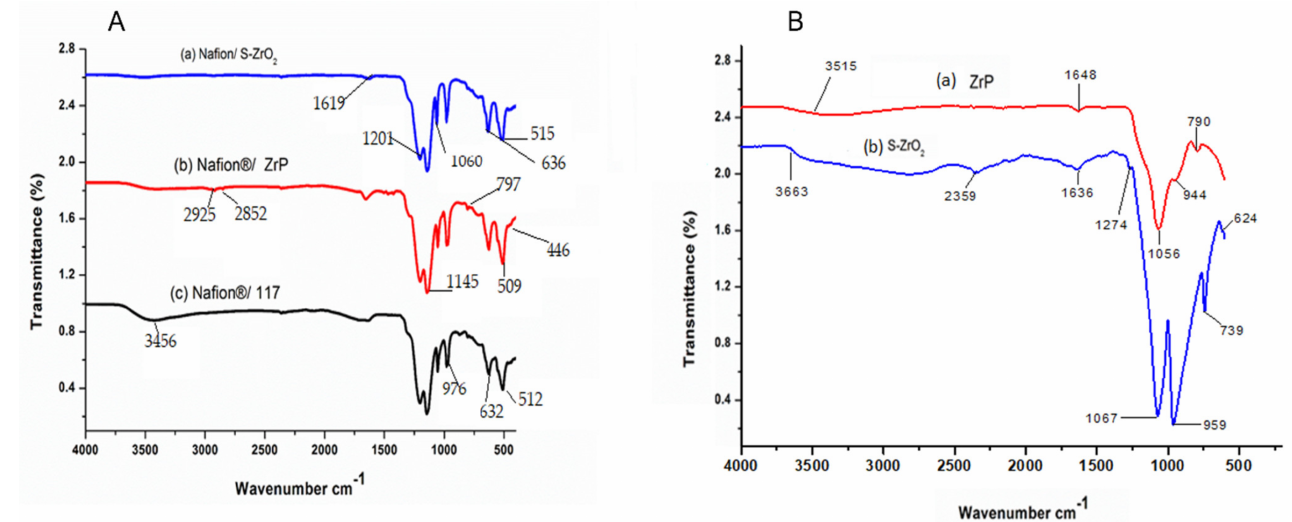
Figure 1. FTIR spectra of ( A ): (a) Nafion ® S-ZrO 2 and (b) Nafion ® ZrP nanocomposite membranes and (c) Nafion ® 117 membrane and FTIR spectra of ( B ): (a) S-ZrO 2 and (b) ZrP